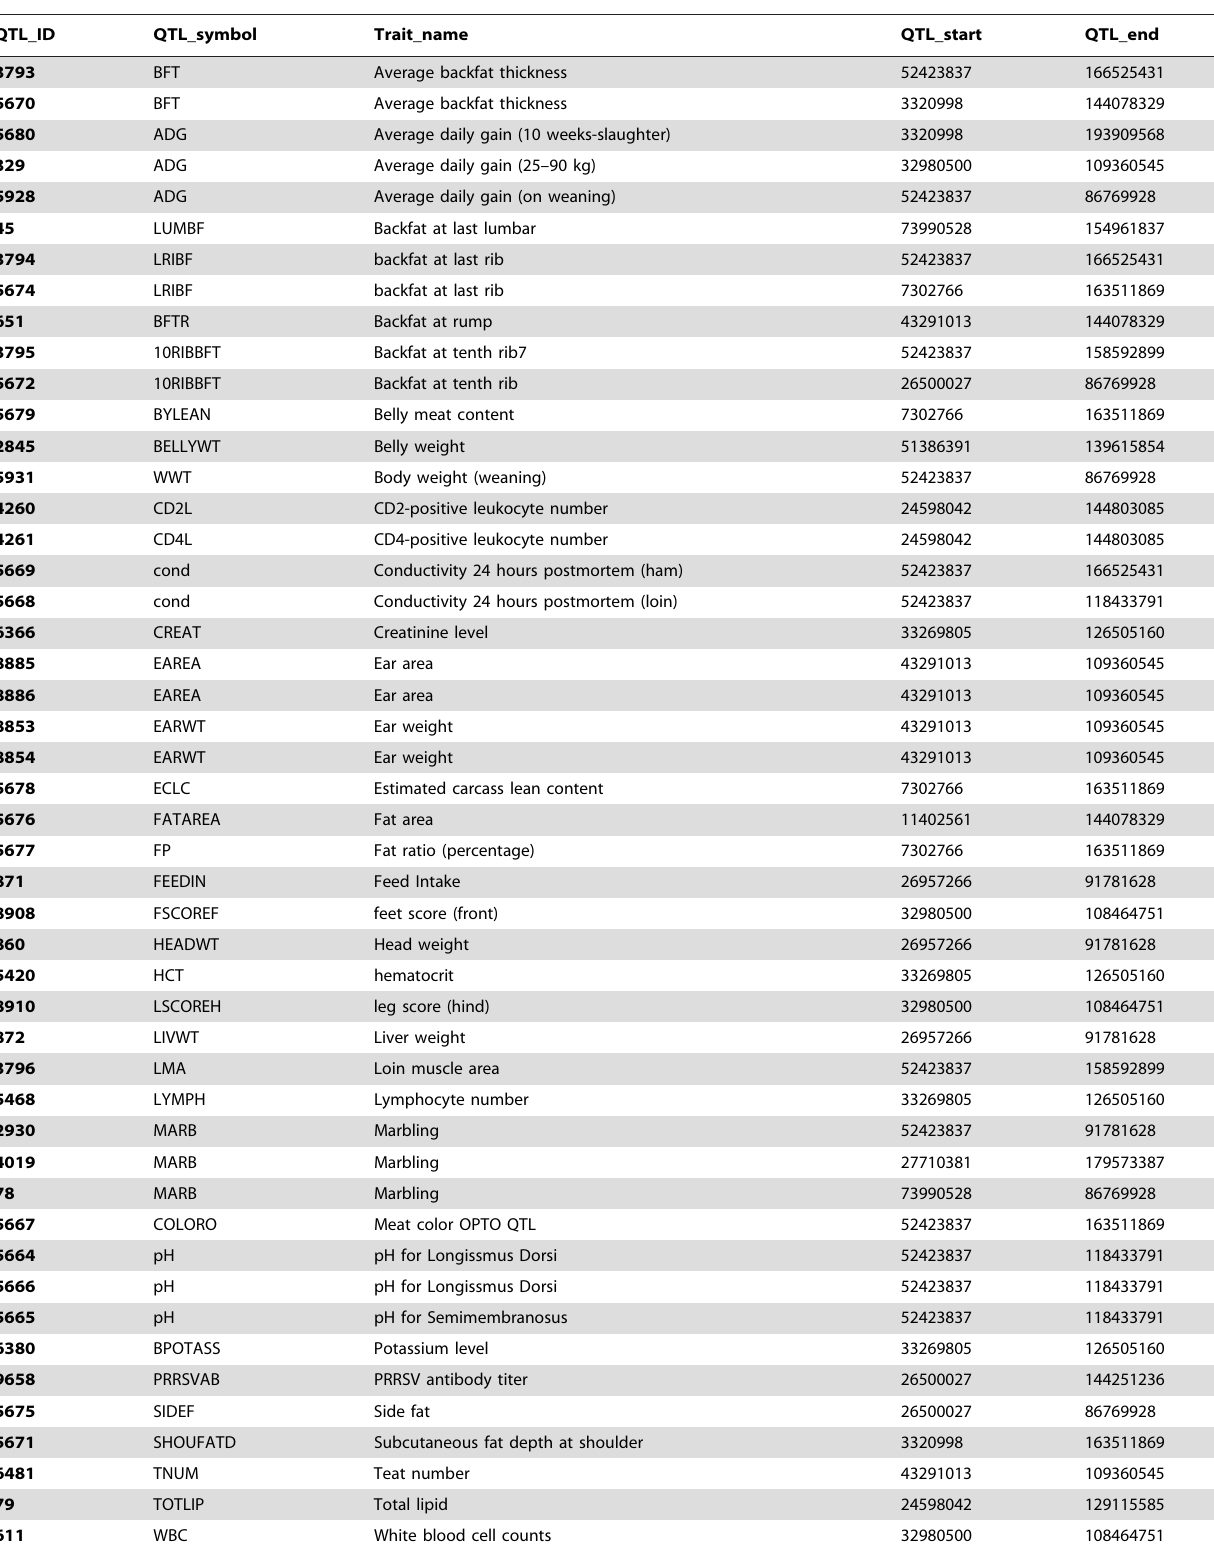
Table 2. Co-localization of QTL map from Pig QTLdb and candidate gene (FOXO3) from IGF1/FoxO